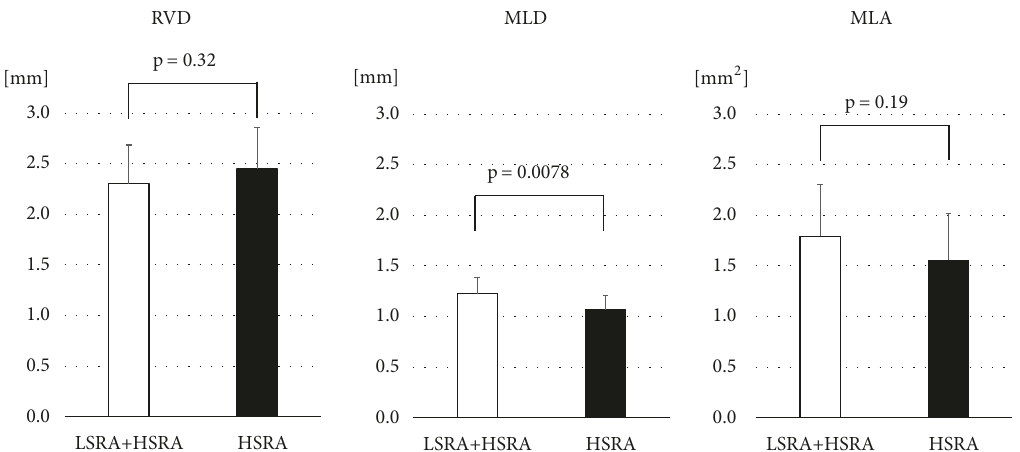
Figure 5: Human Studies MLD and MLA after 1.5-mm Rotablator Burr. Comparison of minimum lumen diameter (MLD) and minimum lumen is (MLA) after high-speed rotational atherectomy (HSRA), low-speed rotational atherectomy (LSRA) following HSRA. RVD = reference vessel